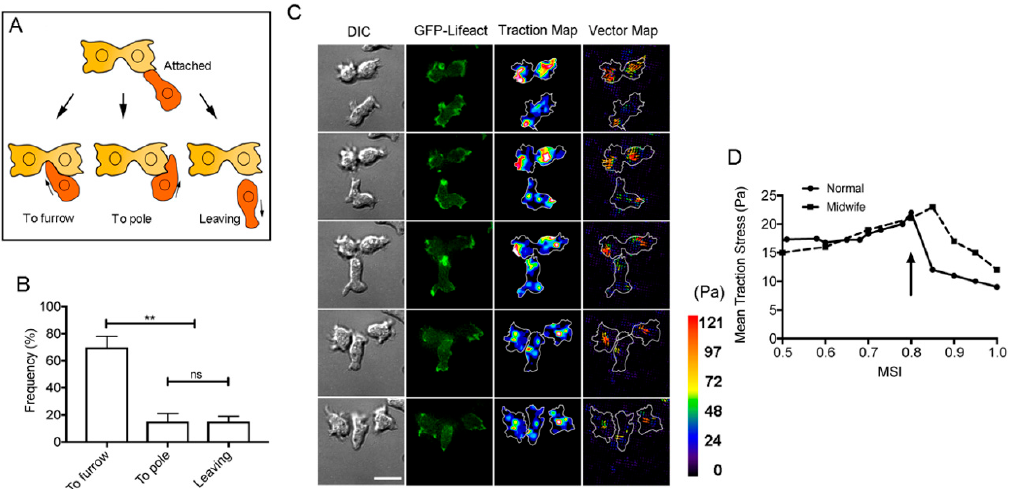
Figure 5. Cell behavior and traction force during cytokinesis D. ( A ) When a migrating cell attaches to a dividing cell, three behaviors were observed. (1) The cell migrates along the surface of the dividing cell toward the cleavage furrow. (2) The cell migrates along the surface of the dividing cell toward the pole. (3) The cell departs from the dividing cell. ( B ) Frequencies of three events. Data are presented as the mean ± SD (n = 62, 43, and 32, three experiments). ** P ≤ 0.0001, ns: not significant, P > 0.05. ( C ) A typical DIC image, a fluorescence image of GFP–lifeact (a marker of actin filaments), a traction map, and the traction vector map during cytokinesis D. The color code indicates the magnitude of traction stress. Bar, 10 µm. ( D ) Representative time course data on the mean traction stress of a dividing cell with (Normal) and without midwife cells (Midwife). To normalize the cell division stages, the mitosis stage index (MSI) was employed as described in Materials and Methods. The arrow indicates the timing when the midwife cell passed through the cleavage furrow of a dividing cell.